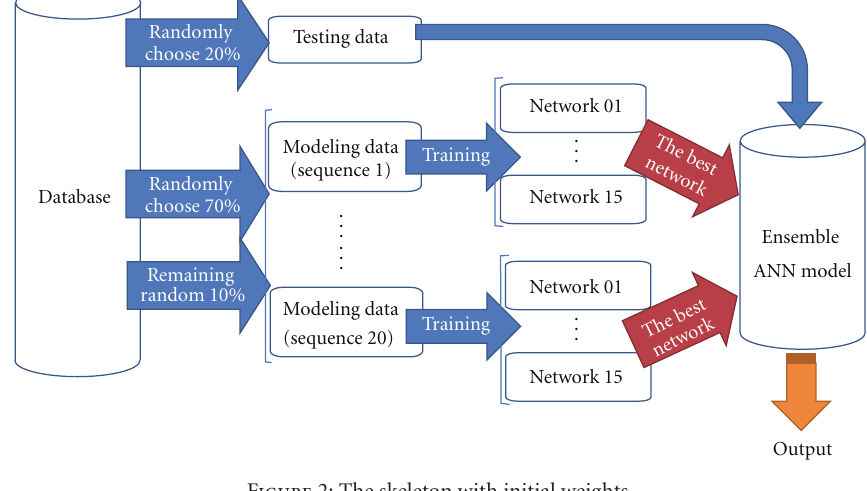
Figure 2: The skeleton with initial weights.